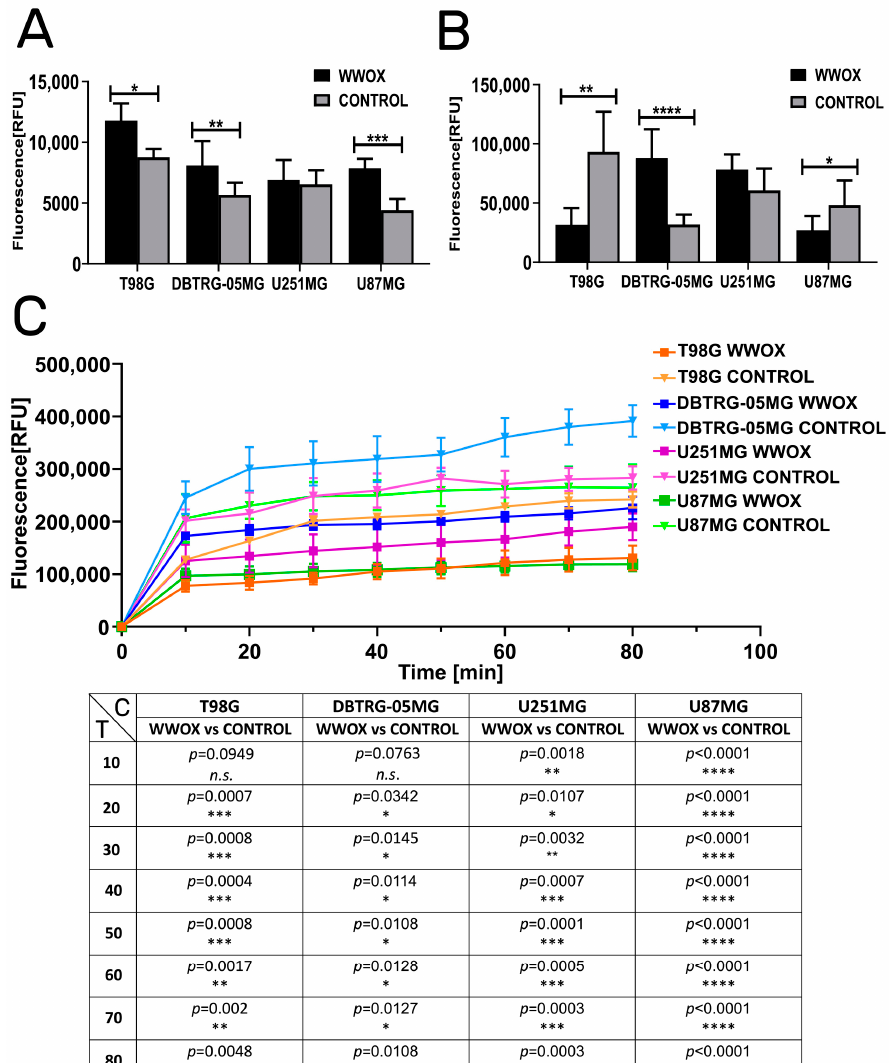
Figure 2. Determining the apoptotic, proliferative, and mitochondrial redox potentials. Plots collect data for T98G, DBTRG-05MG, U251MG, and U87MG cell lines. ( A ) Apoptosis. ( B ) Proliferation. ( C ) Mitochondrial redox potential. T—Time [min]. C—Comparison. p < 0.05 (*), p < 0.01 (**), p < 0.001 (***), p < 0.0001 (****).